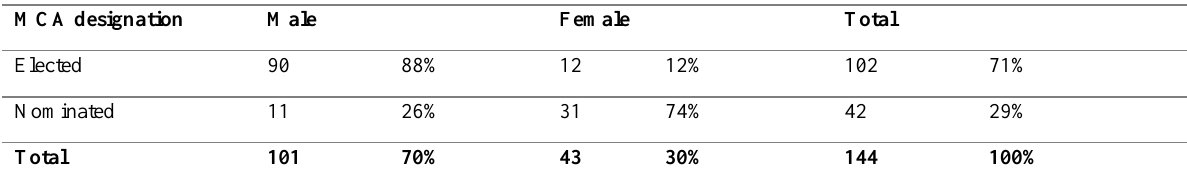
Table 5: MCAs designation by sex (N=144)